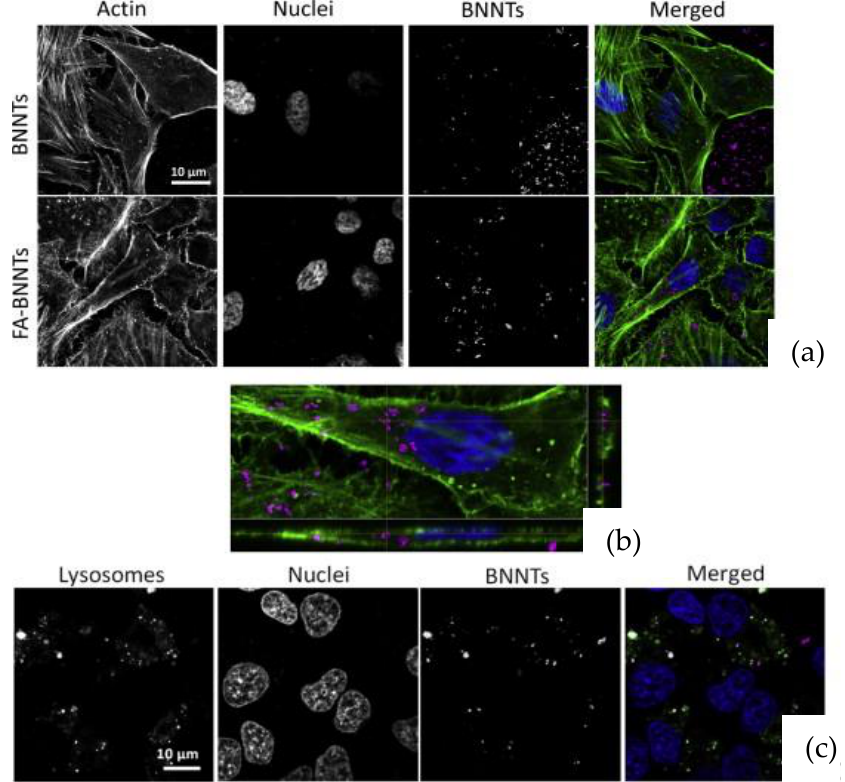
Figure 6. ( a ) Confocal images of HeLa cells treatment with BNNTs and FA-BNNTs; ( b ) FA-BNNTs internalisation by HeLa cells; ( c ) lysosome staining (in green) for FA-BNNT (in pink) co-localisation evaluation. Reproduced with permission from Ref. [58]. Copyright 2015, Elsevier.